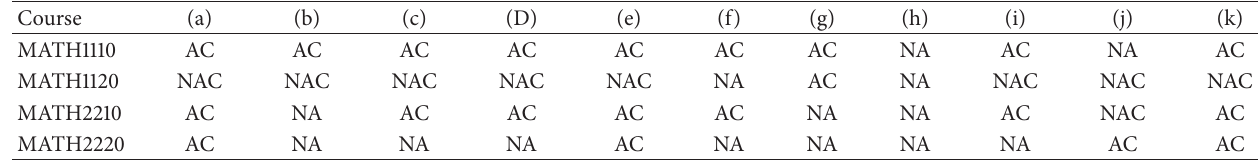
Table 13: Overall average ABET outcomes